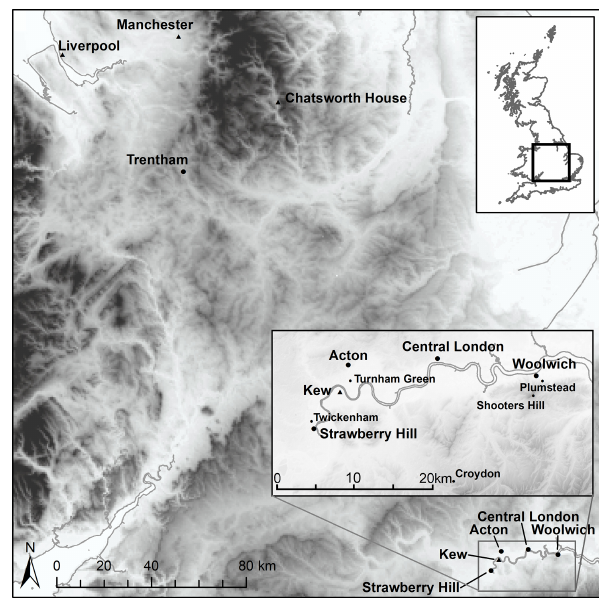
Figure 1. Location of rainfall records used within this study in Staffordshire and London (instrumental rainfall series marked with a triangle; locations of large numbers of non-instrumental records marked with a large circle, small numbers with a small